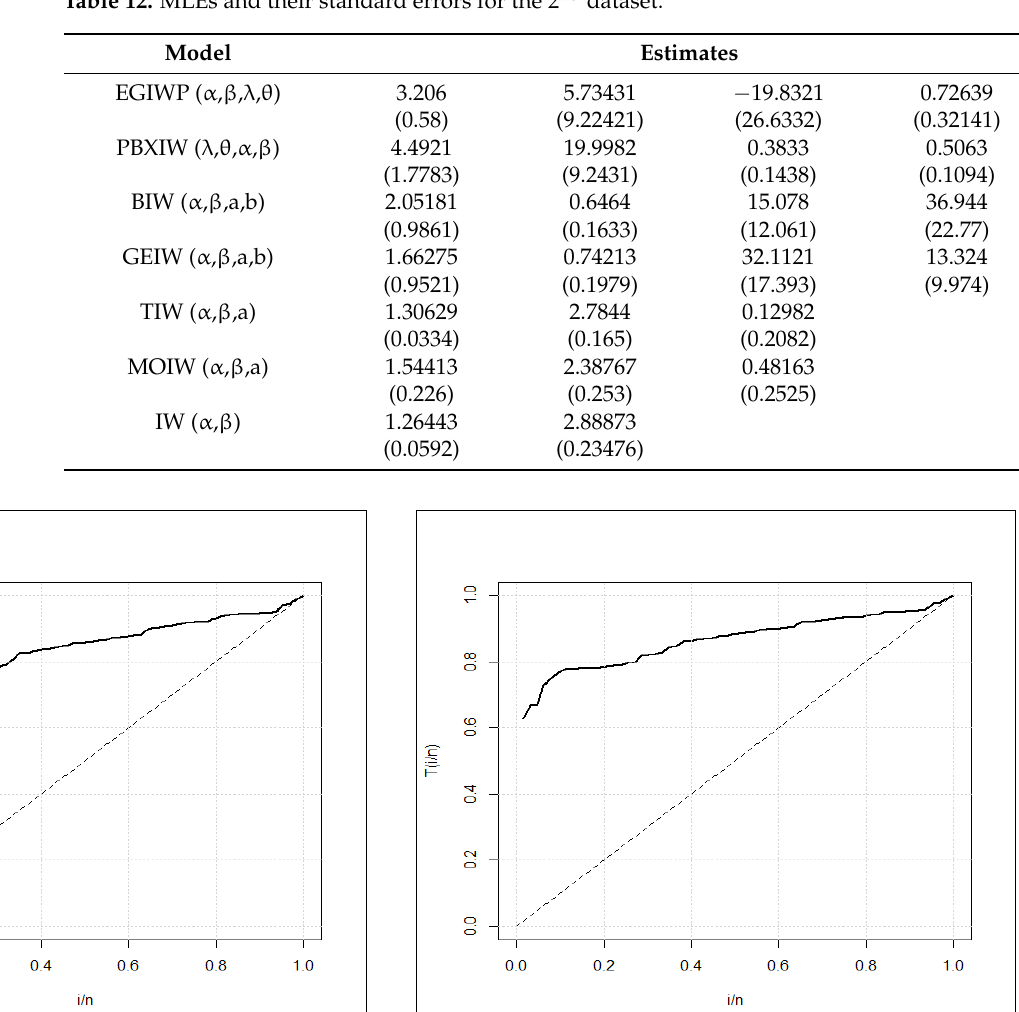
Table 12. MLEs and their standard errors for the 2 nd dataset.